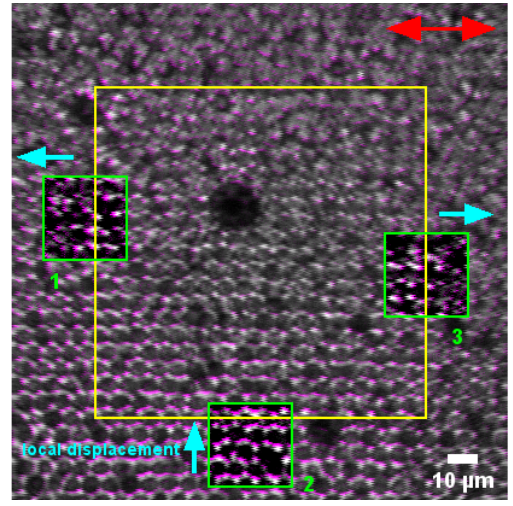
Figure 1. B / W: raw transmission image of the substrate top sur- face patterned with a hexagonal array of pillars. Magenta: pixels of transmission image after irradiation with horizontal polariza- tion (red double-arrow), initial image subtracted. Yellow: Zone of irradiation. Green: Enhanced contrast regions.